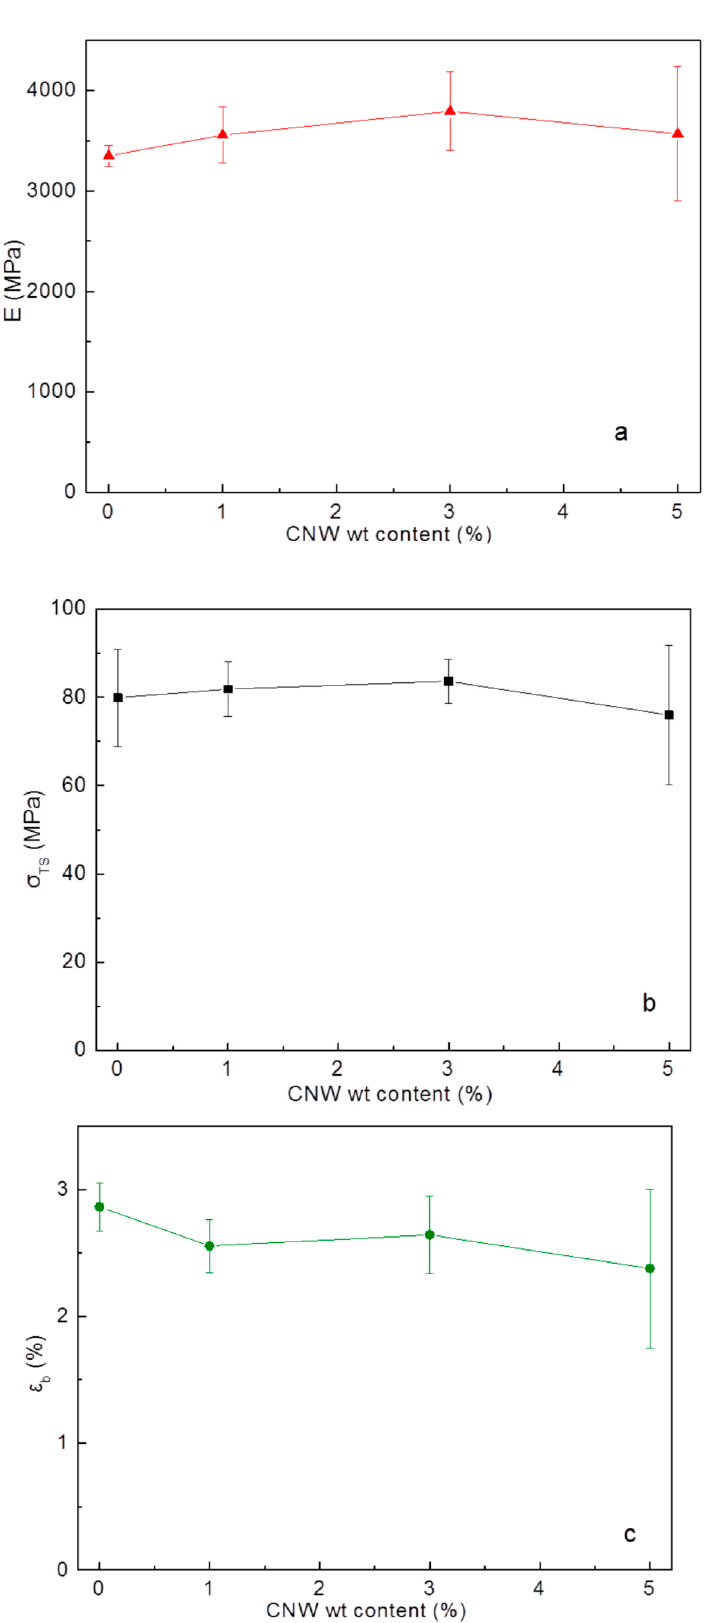
Figure 10. Diagrams of ( a ) modulus of elasticity (E), ( b ) tensile strength ( σ TS ) and ( c ) strain at break ( ε b ) as a function of the weight fraction of the nano-additive into the samples.